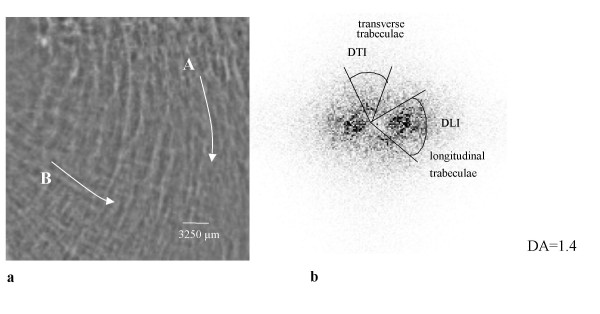
Control case a: ROI of the digitized radiographicimage of calcaneus trabecular bone. b: FFT spectrum A: corresponds to longitudinal trabeculae B: corresponds to transverse trabeculae DLI: Dispersion Longitudinal Index, spreading angle of the longitudinal trabeculae DTI: Dispersion Transverse Index, spreading angle of the transverse trabeculae